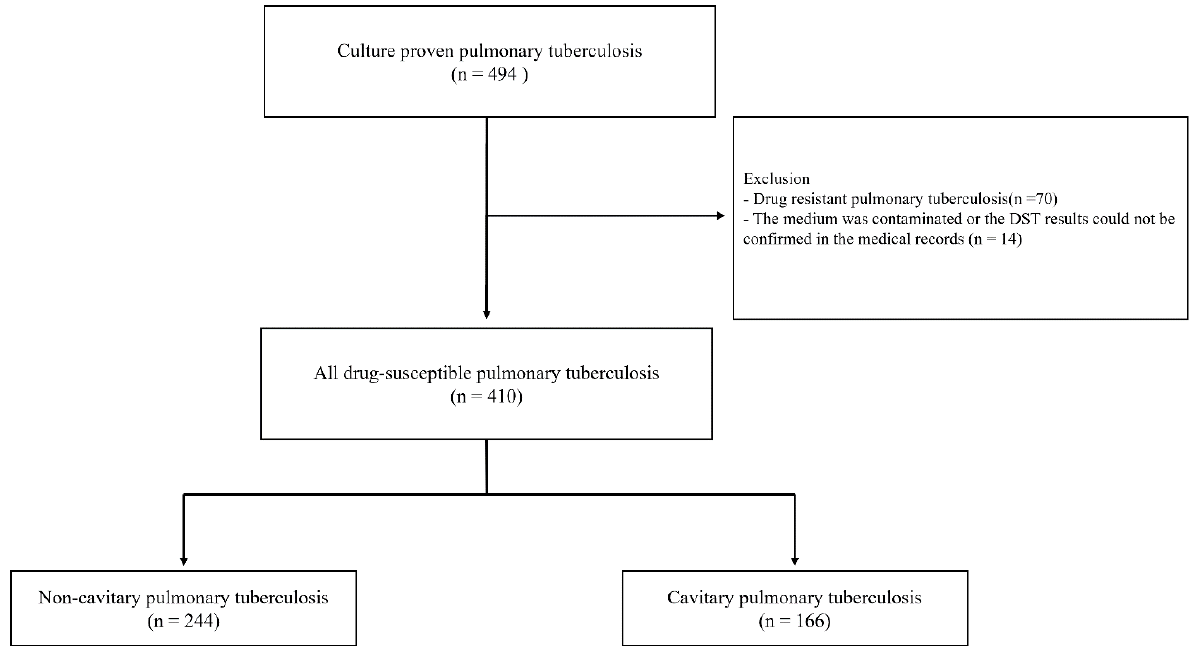
Figure 1. Flow chart of the study. DST, Drug-susceptible test.